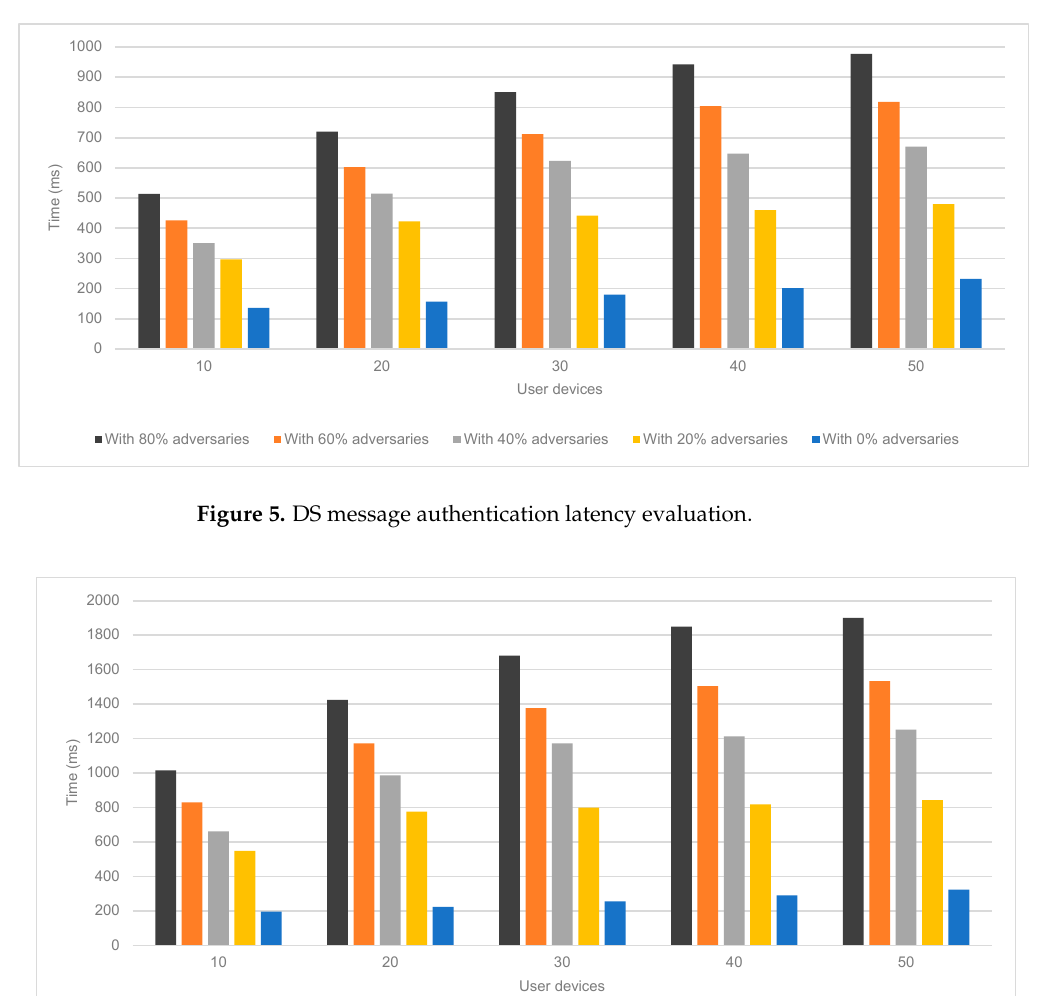
Figure 4. User authentication latency evaluation.